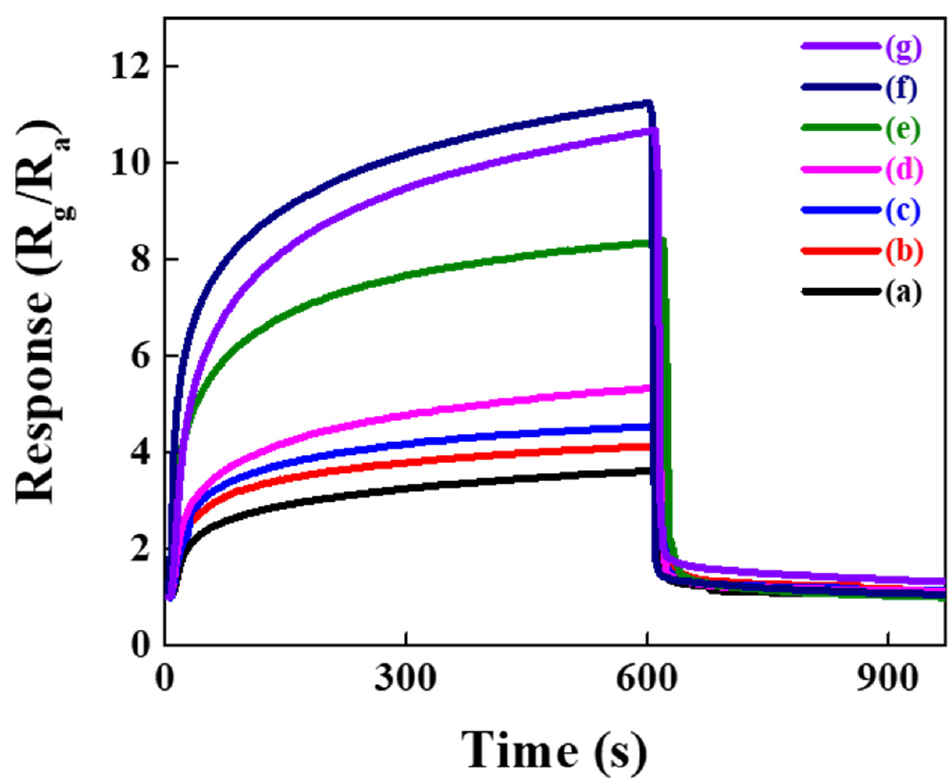
Figure 6. The response curves of ( a ) neat PANI polymer matrix, ( b ) 2.5 wt% PANI/hollow In 2 O 3 nanofiber, ( c ) 5 wt% PANI/hollow In 2 O 3 nanofiber, ( d ) 10 wt% PANI/hollow In 2 O 3 nanofiber, ( e ) 15 wt% PANI/hollow In 2 O 3 nanofiber, ( f ) 20 wt% PANI/hollow In 2 O 3 nanofiber, and ( g ) 25 wt% PANI/hollow In 2 O 3 nanofiber composites with exposure of 1 ppm NH 3 at room temperature.